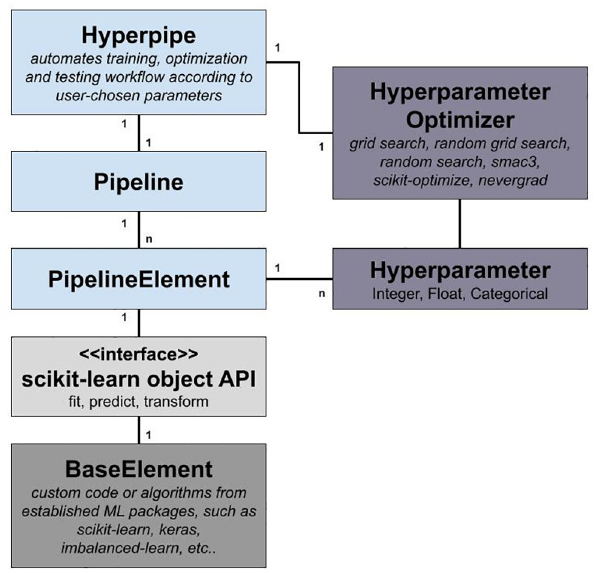
Fig 1. Class architecture. The PHOTONAI framework is built to accelerate and simplify the design of machine learning models. It adds an abstraction layer to existing solutions and is thereby able to simplify, structure, and automate the training, optimization, and testing workflow. Importantly, the pipeline and the workflow are subject to user choices as the user selects a sequence of processing and learning algorithms and parameterizes the optimization and validation workflow. The here depicted class diagram shows PHOTONAI’s core structure. The central element is the Hyperpipe class, short for hyperparameter optimization pipeline, which manages a pipeline and the associated training, optimization, and testing workflow. The Pipeline streams data through a sequence of n PipelineElements . PHOTONAI relies on the established scikit-learn [7] object API, to integrate established or custom algorithms ( BaseElements ) into the workflow. PipelineElements can have n hyperparameters which are subject to optimization by a hyperparameter optimization